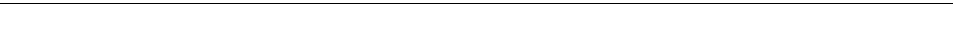
Figure 2. Dollar Value of SFMNP Vouchers Redeemed With Reference to Category of